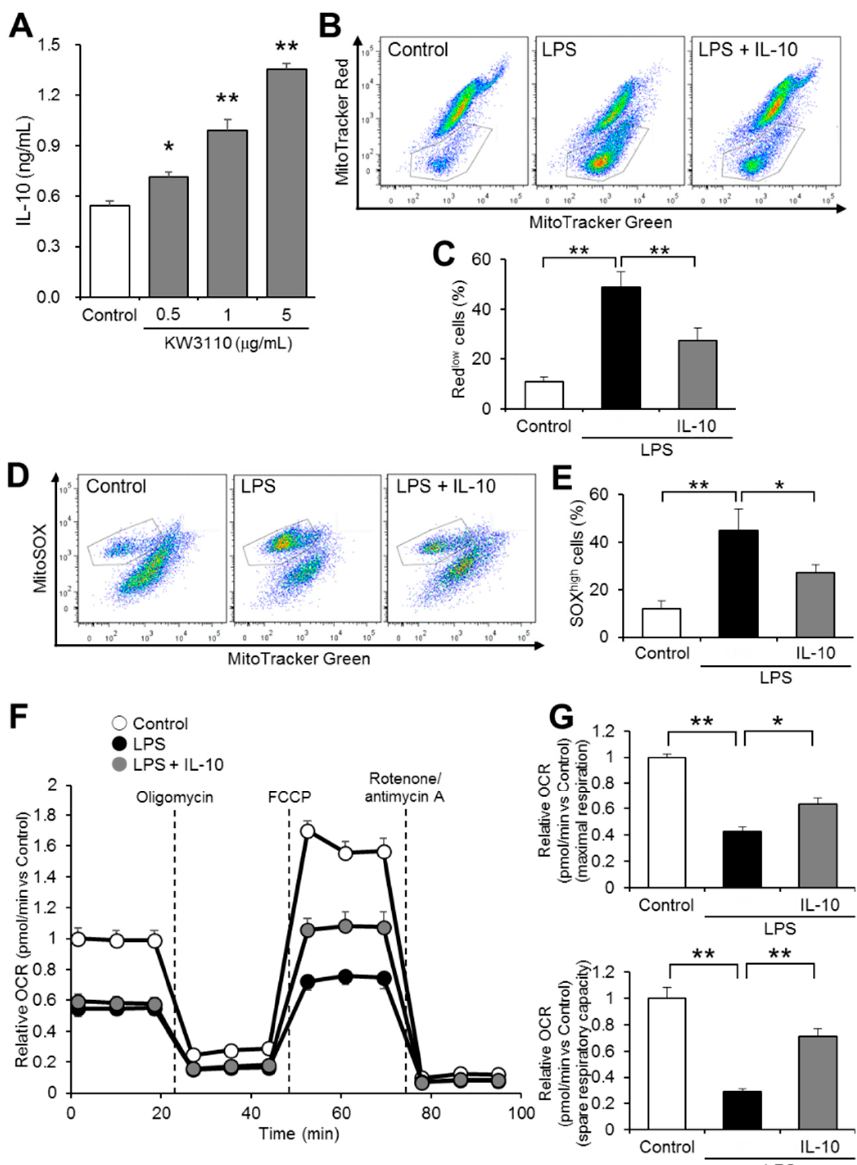
Figure 4. IL-10 treatment suppresses mitochondrial dysfunction in LPS-stimulated J774A.1 cells. ( A ) J774A.1 cells were treated with KW3110 (0.5, 1, or 5 µ g/mL) for 24 h and IL-10 in the supernatant was measured by enzyme-linked immunosorbent assay (ELISA). ( B – E ) Mitochondrial membrane potential and mitochondrial ROS production were measured after cells were treated with IL-10 (1 µ g/mL) and LPS (0.1 µ g/mL) for 24 h. Representative flow cytometry plots of cells labeled with MitoTracker Green (100 nM) and MitoTracker Red (100 nM) are shown ( B ). The ratio of Red low cells to total cells was calculated ( C ). Representative flow cytometry plots of cells labeled with MitoTracker Green (100 nM) and MitoSOX (5 µ M) ( D ). The ratio of SOX high cells to total cells was calculated ( E ). ( F , G ) Mitochondrial respiration in cells was analyzed by an XFe24 Extracellular Flux Analyzer. Real-time measurement of OCR was performed with an XF Cell Mito Stress Test, normalized to the control at 0 min ( F ). Maximal respiration was calculated by subtracting the average relative OCR before oligomycin injection from that between FCCP and rotenone/antimycin A injections. Spare respiratory capacity was calculated by subtracting the average relative OCR between FCCP and rotenone/antimycin A injections from that before oligomycin injection, normalized to the control. Values represent means ± SEM. n = 5. Statistical differences were analyzed by ANOVA followed by Dunnett’s or Tukey’s test. *, p < 0.05; **, p < 0.01.